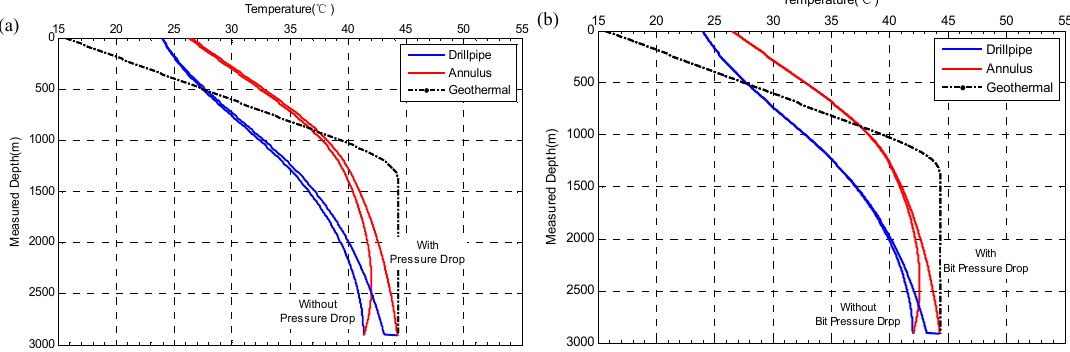
Figure 5. ( a ) Influence of pressure drops of the whole wellbore on temperature profile ( b ) Influence of pressure drop of drill bit on temperature profile.